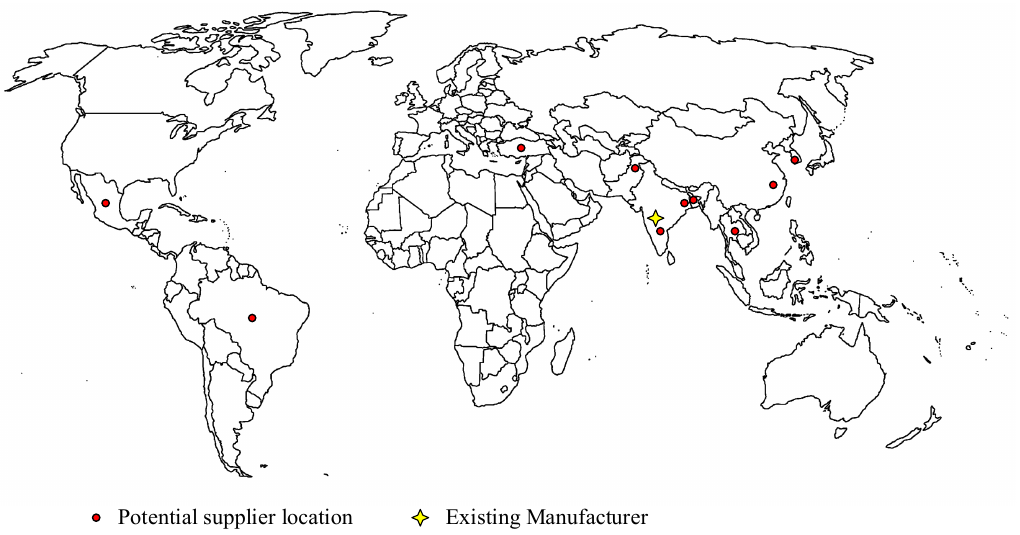
Figure 1. Supply network of the problem under consideration. Table 2. Model input data.